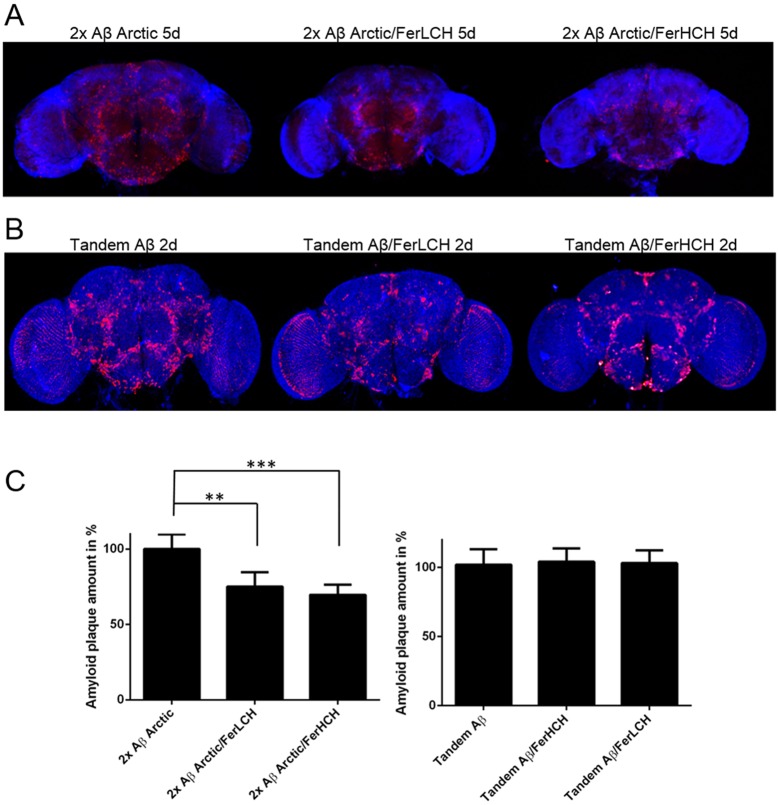
Co-expression of ferritin subunits decreases the deposition of monomeric but not tandem Aβ. (A) Fewer Aβ Arctic deposits are seen in Drosophila brains when ferritin is co-expressed. (B) Co-expression of either FerHCH or FerLCH did not alter the number of tandem Aβ42 brain deposits. Aβ is shown in red (6E10 anti-Aβ antibody) and nuclei (TOTO-3) in blue. Images are z-stack projections using identical microscope settings with a 10× objective. (C) Quantification of five representative fly brains revealed that ferritin reduces Aβ deposition when expressed as a monomer but not when expressed as the tandem construct. Statistical significance was determined by two-way ANOVA (**P<0.01, ***P<0.001). Error bars show s.d. ‘2×’ indicates two transgenes; otherwise, only one transgene is present.